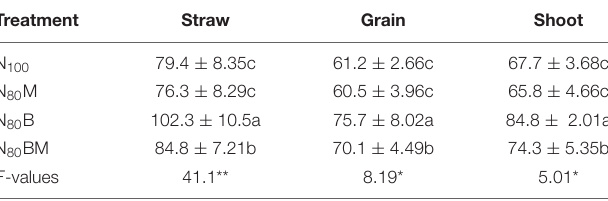
TABLE 3 | Effects of applying rice straw biochar and/or leguminous cover crop residue on physiological N-use efficiency of rice after harvesting plants.